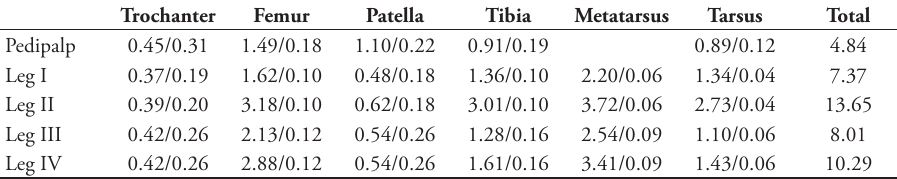
Table 2. Pedipalp and leg measurements (mm) of Lobonychium palpiplus Roewer, 1938, female, length/width. Trochanter Femur Patella Tibia Metatarsus